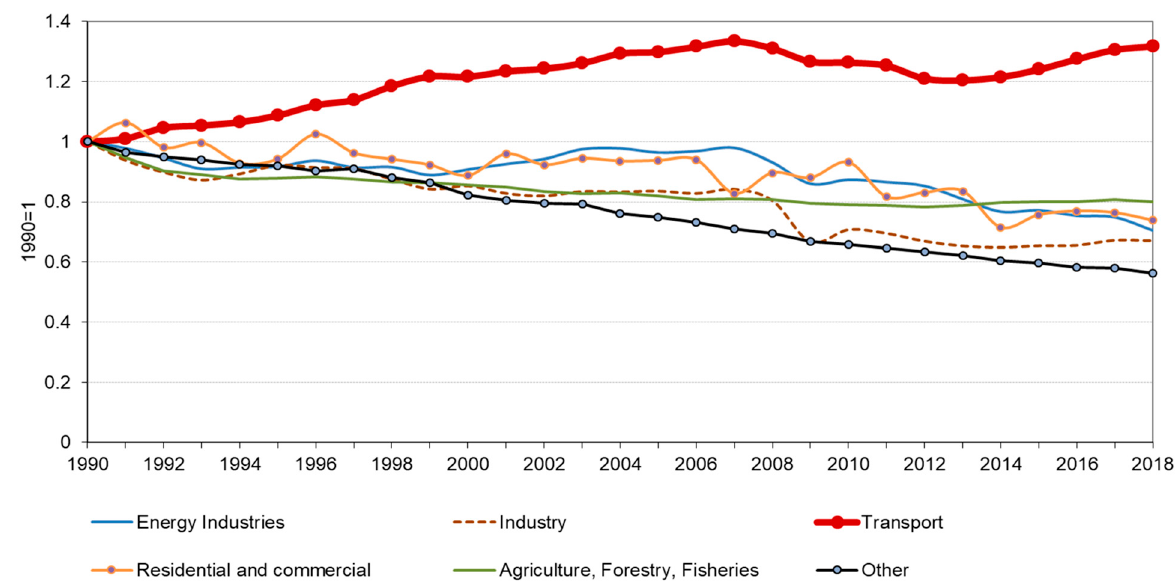
Figure 1. Development of GHG-emissions in the EU-27 in the different sectors (and transport modes) from 1990–2018 (1990 = 1) (Data source: [1]).